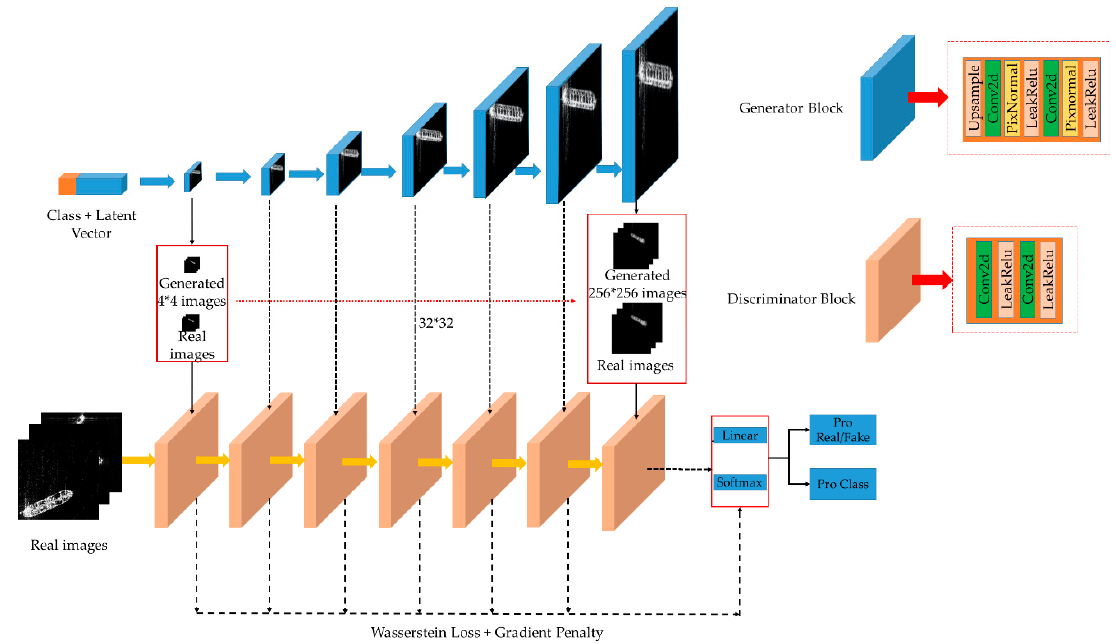
Figure 2. Our proposed network structure.